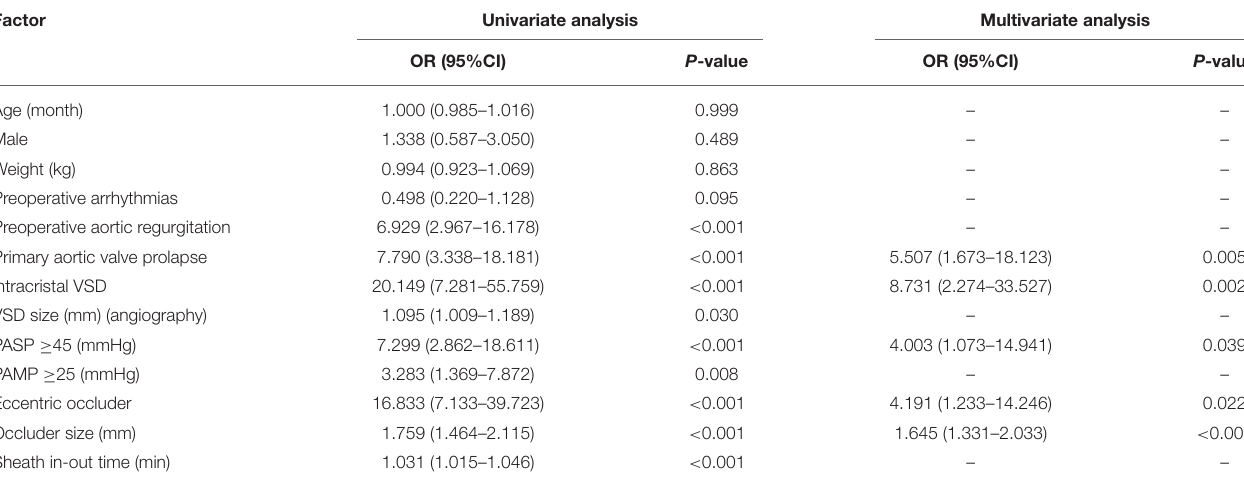
TABLE 3 | Univariate and multivariate logistic analyses of risk factors for unplanned surgery after transcatheter closure of